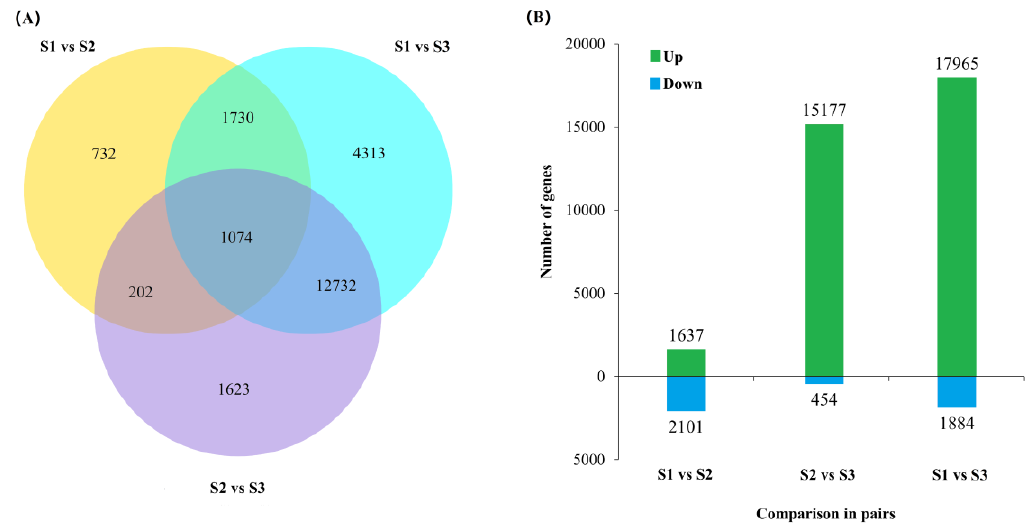
Figure 2. DEGs (di ff erentially expressed genes) in di ff erent combinations. ( A ) Venn diagram of DEGs. Figure 2. DEGs (differentially expressed genes) in different combinations. ( A ) Venn diagram of ( B ) Expression levels of DEGs in di ff erent combinations at di ff erent flower development DEGs. ( B ) Expression levels of DEGs in different combinations at different flower development stages.